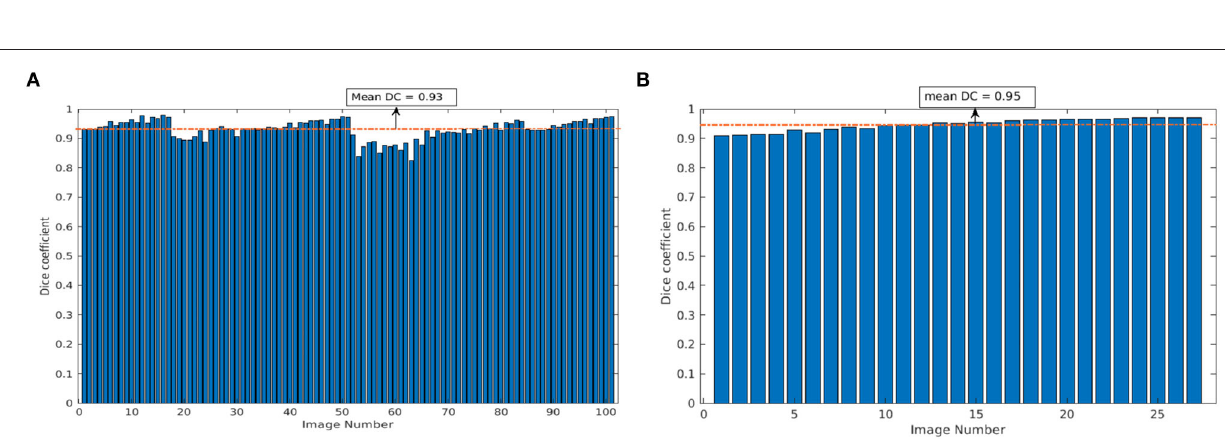
FIGURE 7 | Evaluation of image segmentation on the references data set from Scharr et al.: Dice coefficient of arabidopsis top-view model over 100 and 27 images for single- and multi-tray experiments, respectively (A,B) . The dotted orange line represents the mean DC